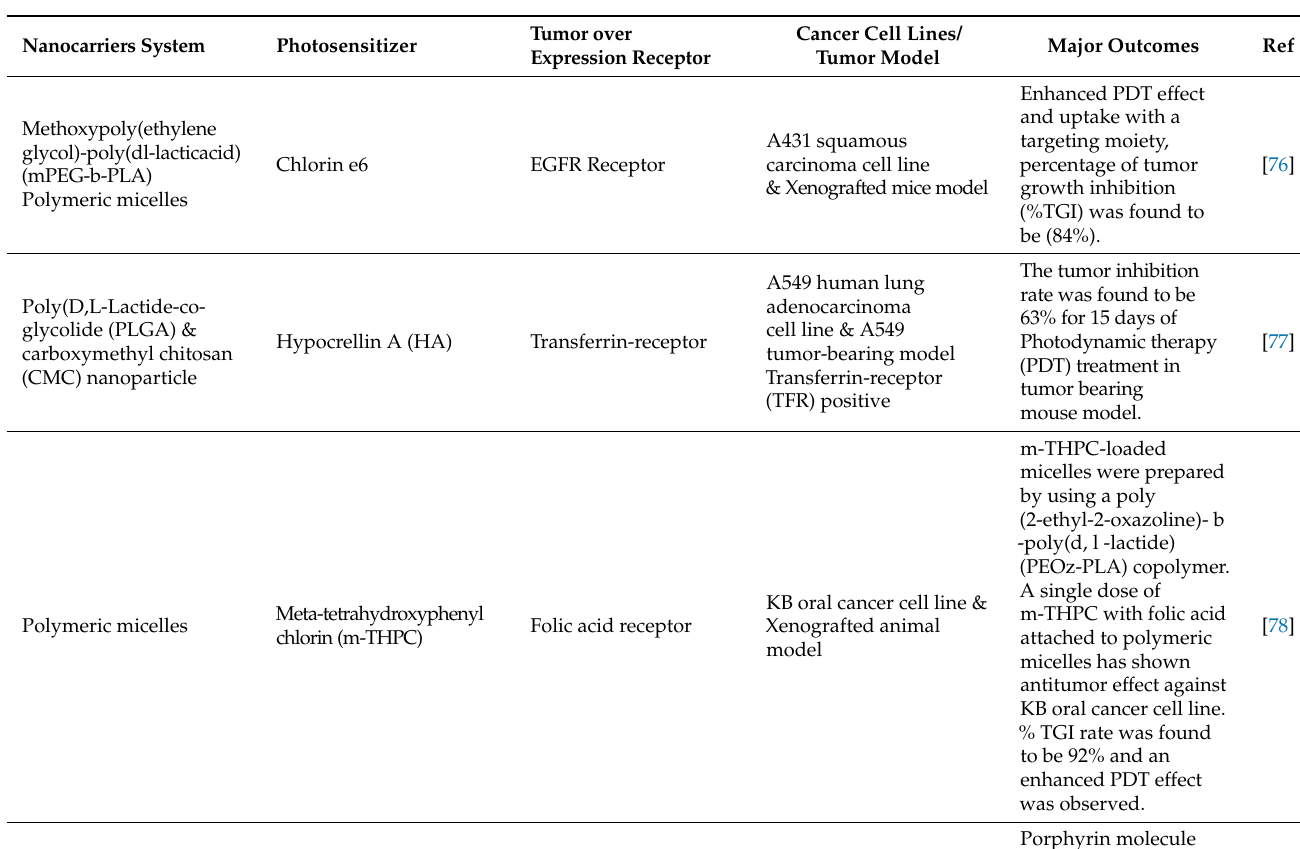
Table 2. Examples of recent major outcomes on nanoparticles-mediated photosensitizer delivery to the tumor by utilizing the overexpressed receptors site and their